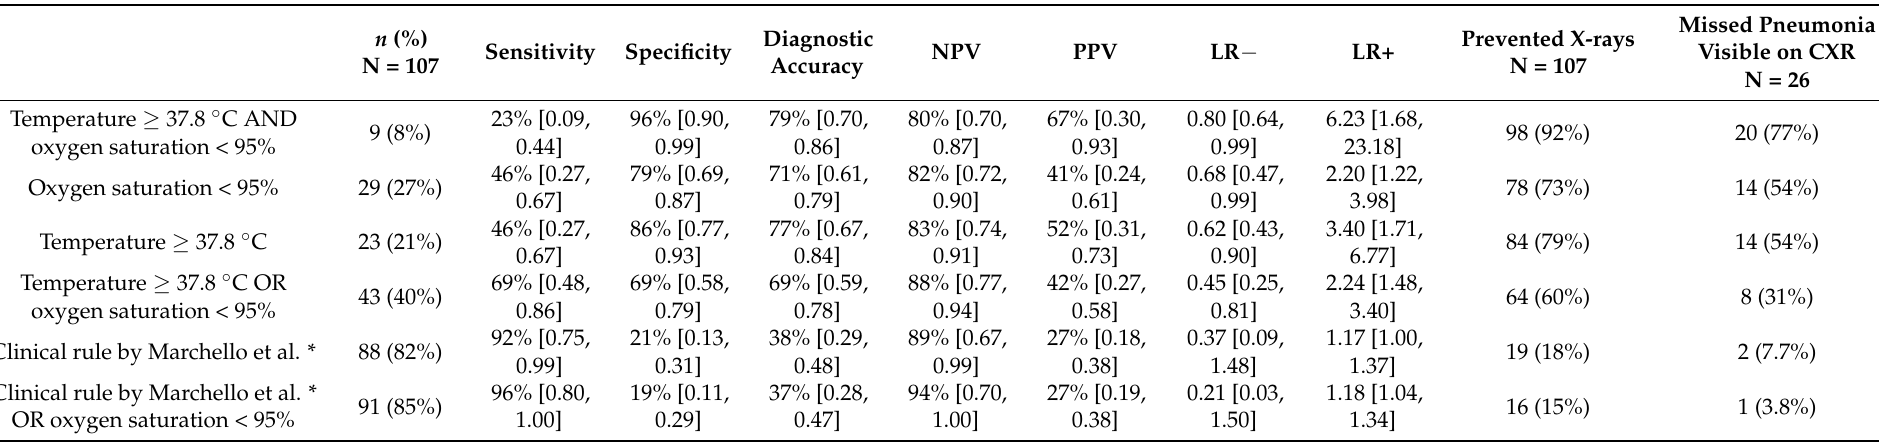
Table 3. Diagnostic performance of selected vital signs according to the results of the multivariate logistic regression and by the clinical rule by Marchello et al. for pneumonia visible on chest X-rays (CXR+).